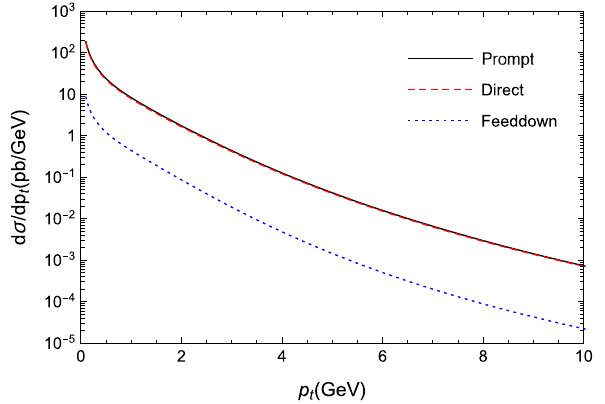
Fig. 2 The p t distributions of direct J /ψ production and that from heavier charmonia